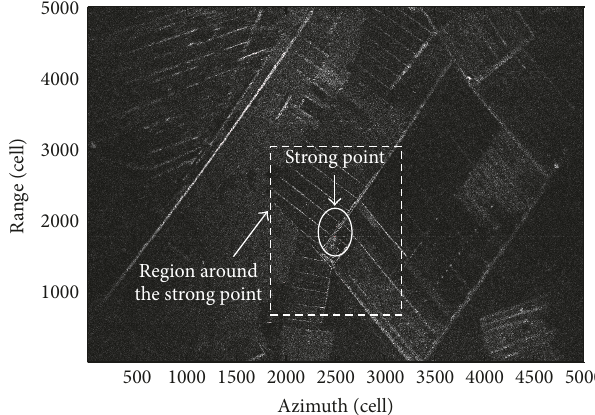
Figure 8: Imaging result with CF-RCMC (monostatic SAR). The image is well focused, particularly in the region around the strong